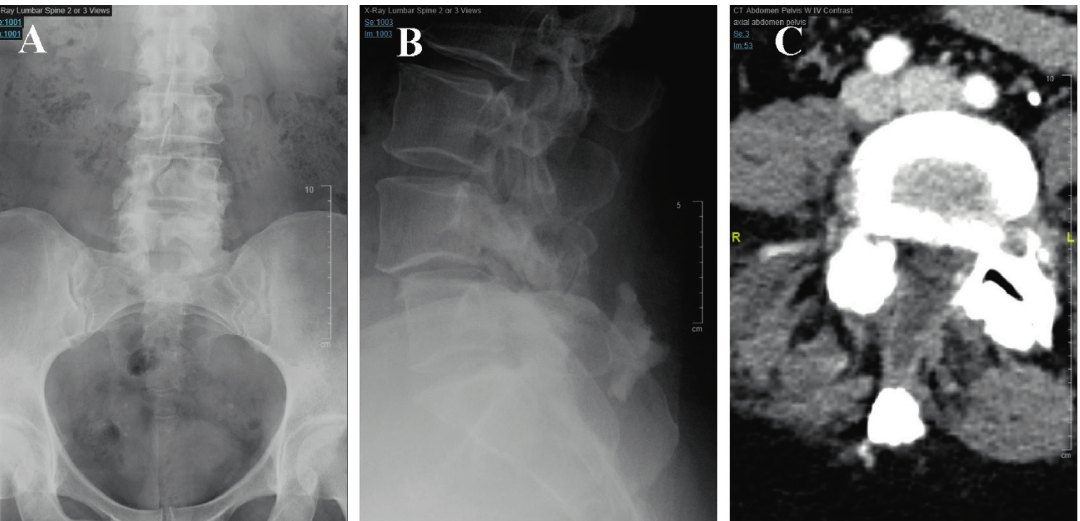
Figure 2: Preoperative X-ray and CTscan. (a) AP X-ray demonstrates the spina bifida occulta at L4-5; note the aberrant lamina. (b) Lateral X-ray demonstrates the L4-5 spondylolisthesis and the posterior subcutaneous calcification. (c) Axial CT image demonstrates the left L4-5 abnormal facet complex and the subcutaneous calcification.